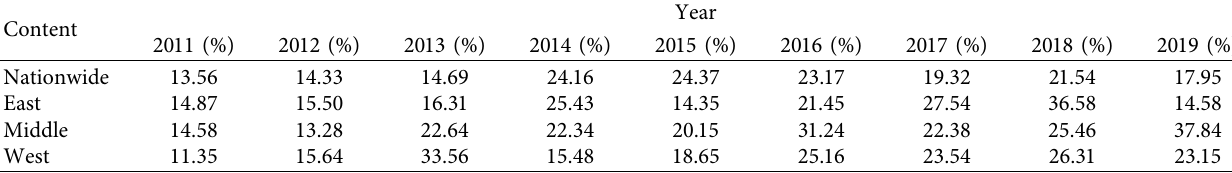
Table 2: Annual growth rate of China’s overall and regional tourism carbon emissions from 2010 to 2019.